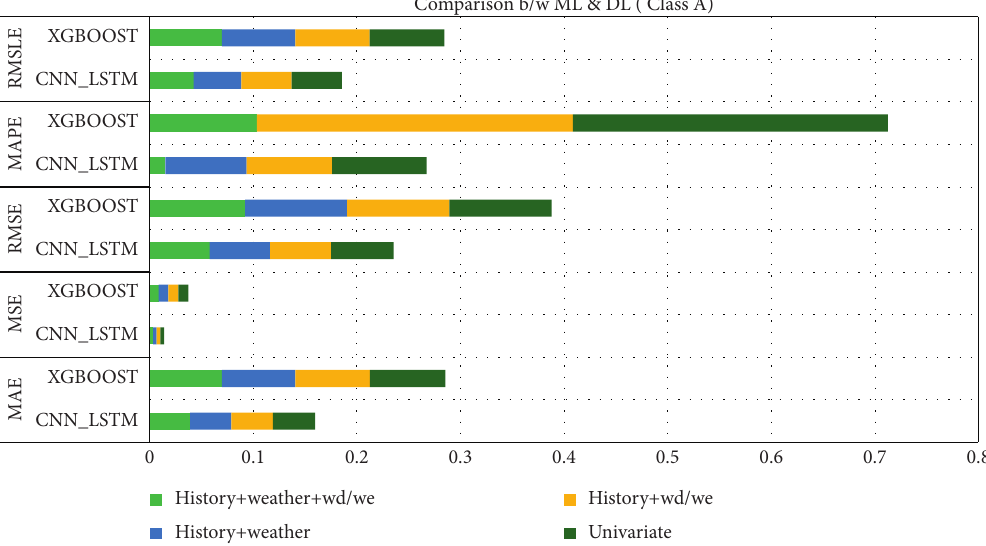
Figure 7: Comparison between best machine learning and deep learning models. Table 14: Computational time for machine learning models.